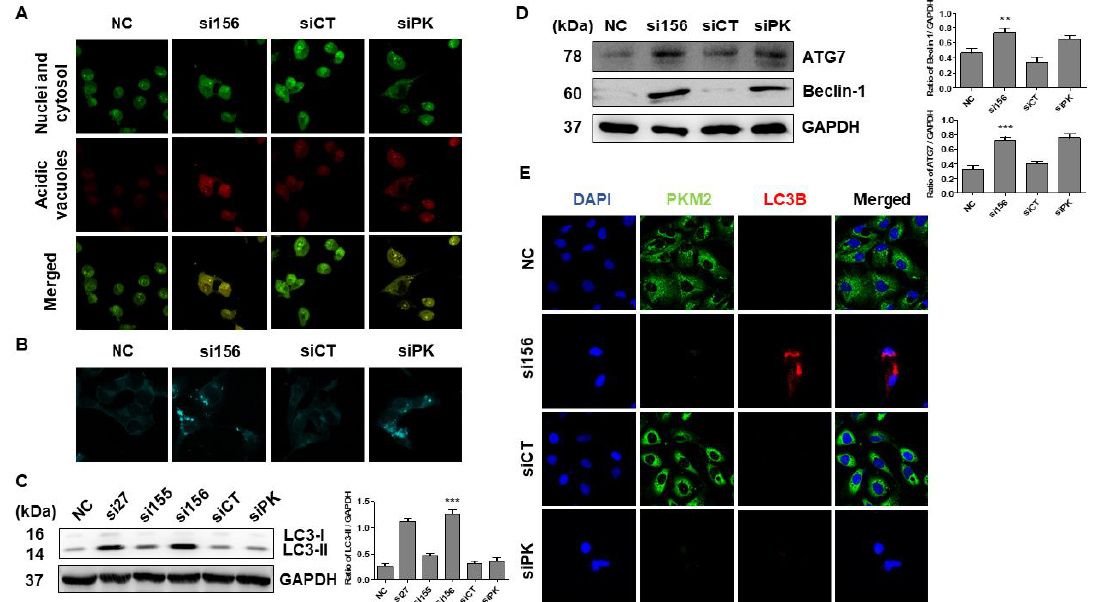
Figure 5. Evaluation of induction of autophagy after PKM2 expression knockdown. ( A ) 786-O cells were transfected with specified siRNAs and stained with acridine orange (1 μg/mL). Formation of acidic vesicular organelles (AVOs) was observed under a confocal microscope at 400× magnification. Fluorescent green staining in cytoplasm and nucleus and fluorescent bright red or orange-red staining of autophagic vacuoles were observed. ( B ) Analysis of autolysosome formation through MDC staining. Cells were transfected, stained with MDC (50 μM), and examined using confocal microscopy. Scale bars indicate 50 μm. ( C , D ) Western blot analysis of autophagic proteins in 786-O cells. Immunoblotting was performed using whole-cell lysates, and GAPDH was used as internal loading control. Representative blots are shown. Ratios of LC3-II/GAPDH and beclin 1/GAPDH were measured and depicted as bar graphs. One-way ANOVA was used to compare means of different groups. Differences between means were considered significant at p < 0.05 using Tukey’s multiple comparison test; ** p < 0.01, and *** p < 0.001 as compared with normal control cells. ( E ) Immunofluorescence analysis was performed to evaluate expression of light chain 3B (LC3B) after siRNA transfection and observed under a confocal microscope at 400× magnification. Higher LC3B expression (indicated by red fluorescence) was observed in si156-transfected cells than in siPK-transfected, normal control, and negative control cells. DAPI was used for nuclear staining. Alexa Fluor 488-conjugated goat anti-rabbit antibody and goat anti-mouse IgG (H+L) cross-adsorbed secondary antibody Rhodamine Red-X were used to detect PKM2 and LC3B, respectively.